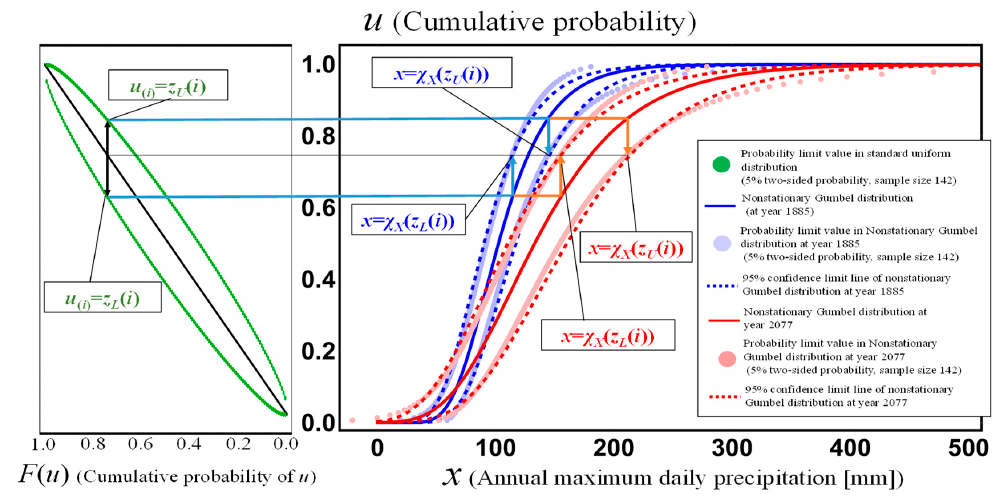
Figure 6. Construction process for the 95% confidence interval of the non-stationary extreme value distribution using probability limit method test. n is the total number of observed data. The blue solid and dashed lines are the non-stationary Gumbel distribution and its 95% confidence limit lines, respectively, for 1885. The red solid and dashed lines are the non-stationary Gumbel distribution and its 95% confidence limit lines, respectively, in 2077 (i.e., a future prediction). Green dots, blue dots, and red dots denote the probability limit values with a 5% two-sided probability in the standard uniform distribution, the non-stationary Gumbel distribution in 1885, and the non-stationary Gumbel distribution in 2077, respectively.